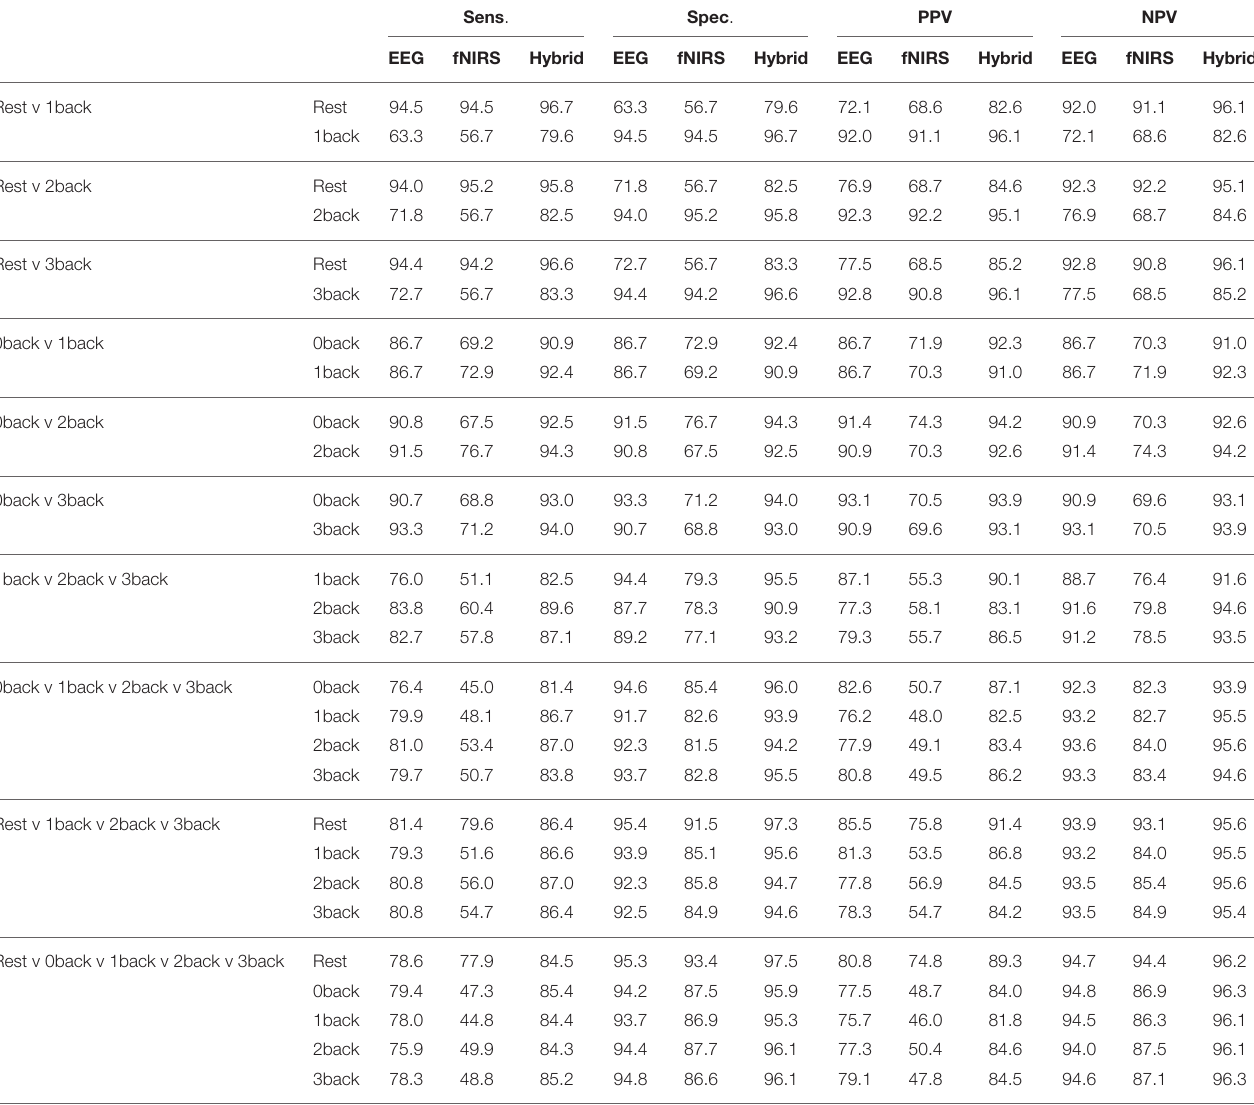
TABLE 4 | Sensitivity (Sens.), specificity (Spec.), positive predictive value (PPV), and negative predictive value (NPV) are listed in percentage (%) for all classification cases (binary and multi-class) and all systems (EEG, fNIRS, Hybrid). Sens . Spec